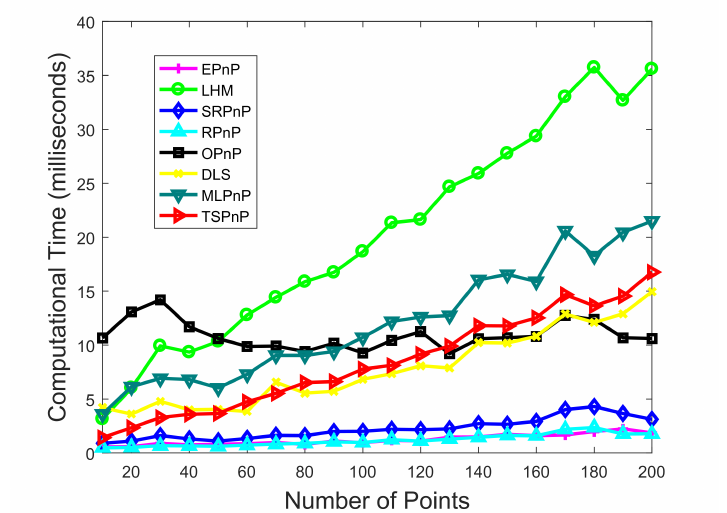
Figure 10. The distribution of average running